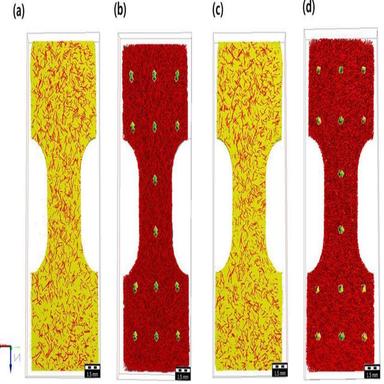
3D microstructural characterization of the longitudinally and transversely oriented fiber distribution in the SBF/PA6,6 composites: (a) external and (b) internal fiber achitecture images of the longitudinal specimen; and (c) external and (d) internal fiber achitecture images of the transverse specimen.